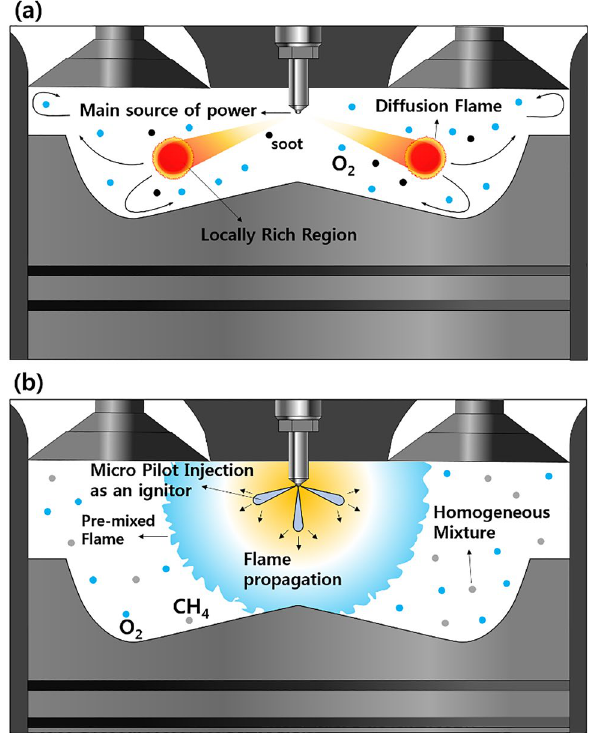
Figure 3. Comparison of combustion technologies: ( a ) diesel combustion and ( b ) MPDF combustion in a compressed ignition